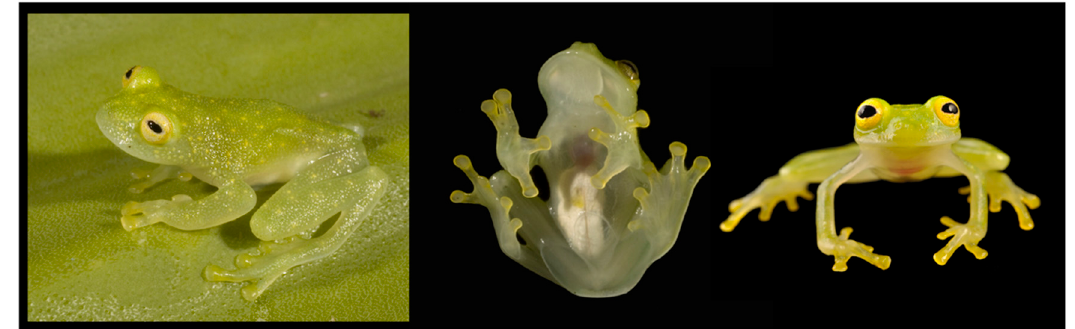
Figure 117. Hyalinobatrachium pellucidum in life. ( Left and center ): Male from R í o Napinaza, Morona Santiago province, Ecuador, QCAZ 42000. ( Right ): Male from Miazi Alto, Zamora Chinchipe province, 1250 m, QCAZ 41648. Photos by Luis A. Coloma.